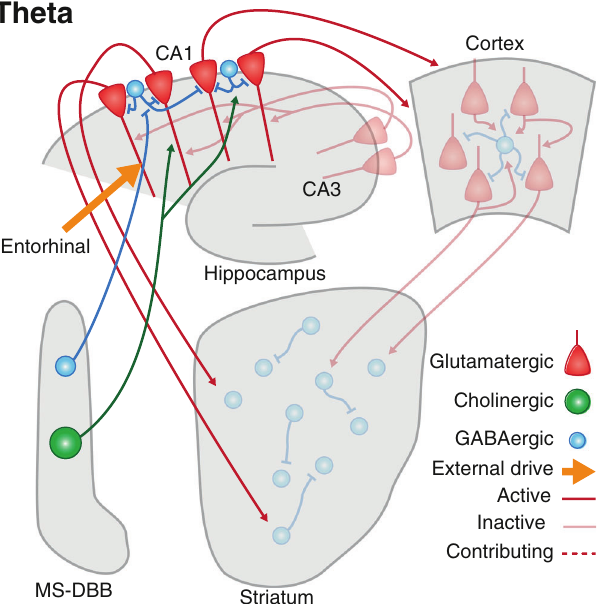
Fig. 2 Theta oscillations depend upon pacing from the MS-DBB and excitatory drive from the entorhinal cortex. Both the striatum and cortical regions receiving input from CA1/subiculum that show theta as well